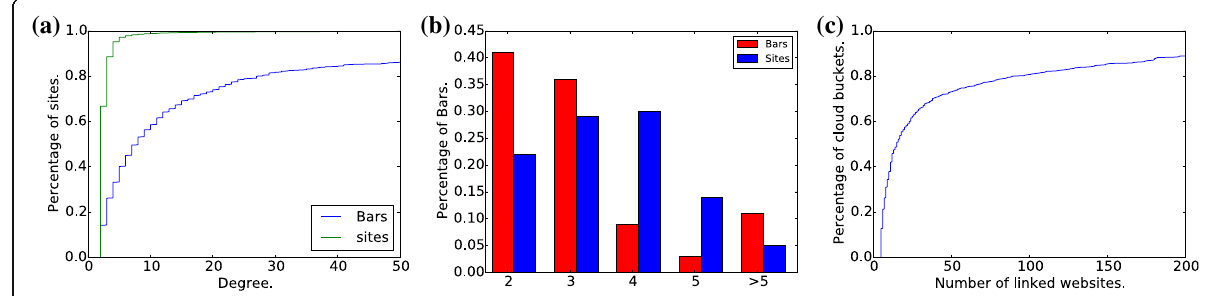
Fig. 7 Bars play critical roles in attack infrastructures. a Cumulative distribution of degrees per sites. b Percentage of Bars in each position of redirection path (Ignoring those traces with length of 2). c Cumulative distribution of number of in-degrees per Bar.